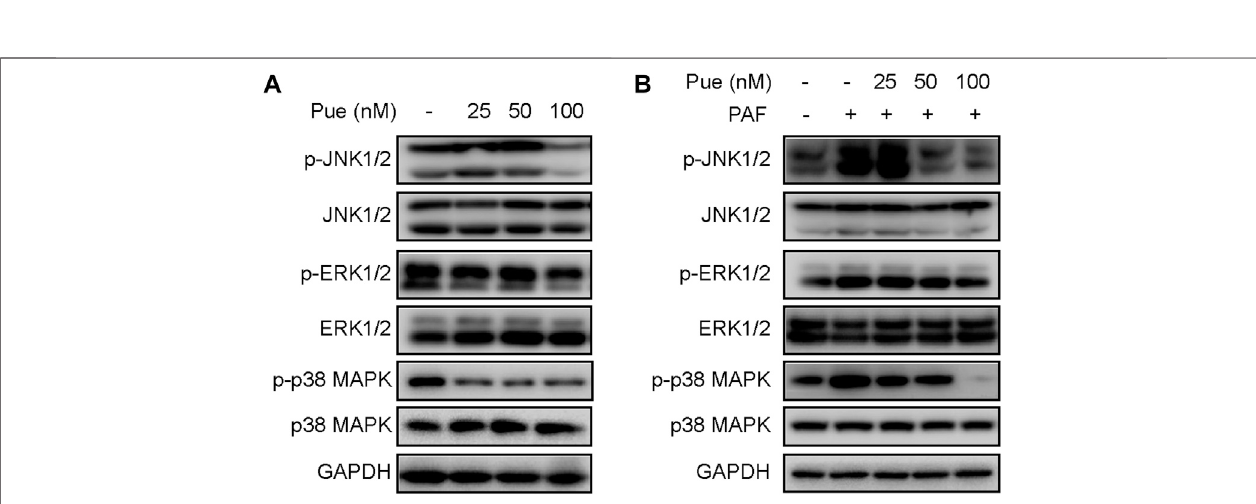
( Figure 5B ), further con fi rming that puerarin markedly inhibited the migration of HPSCs.